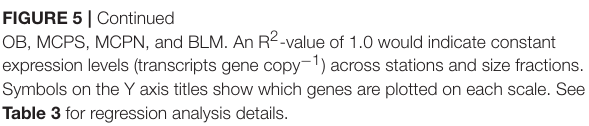
Table 3 for regression analysis